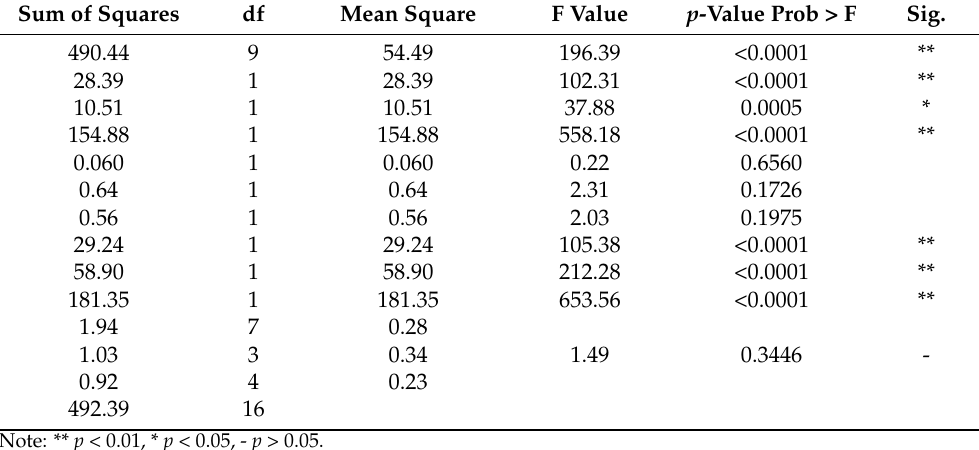
Table 2. Analysis of variance of response surface test data results of content of triterpenoids.